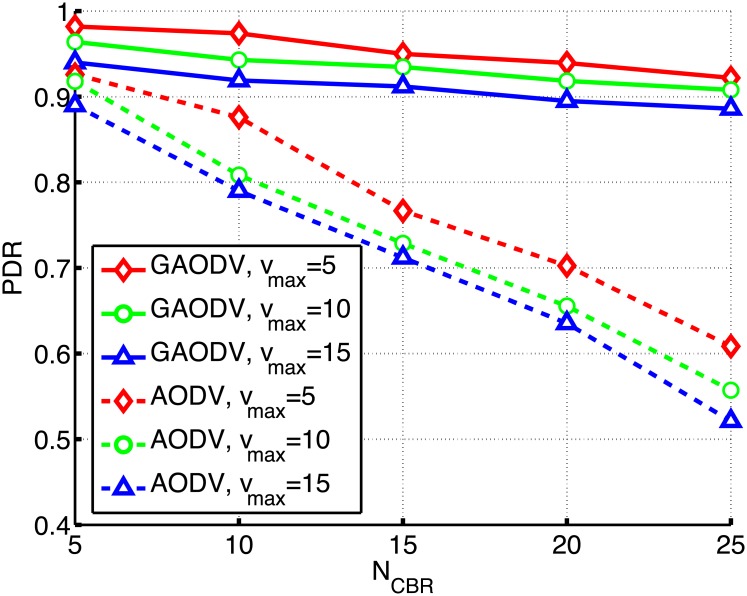
Packet delivery ratio for the change of NCBR and vmax.